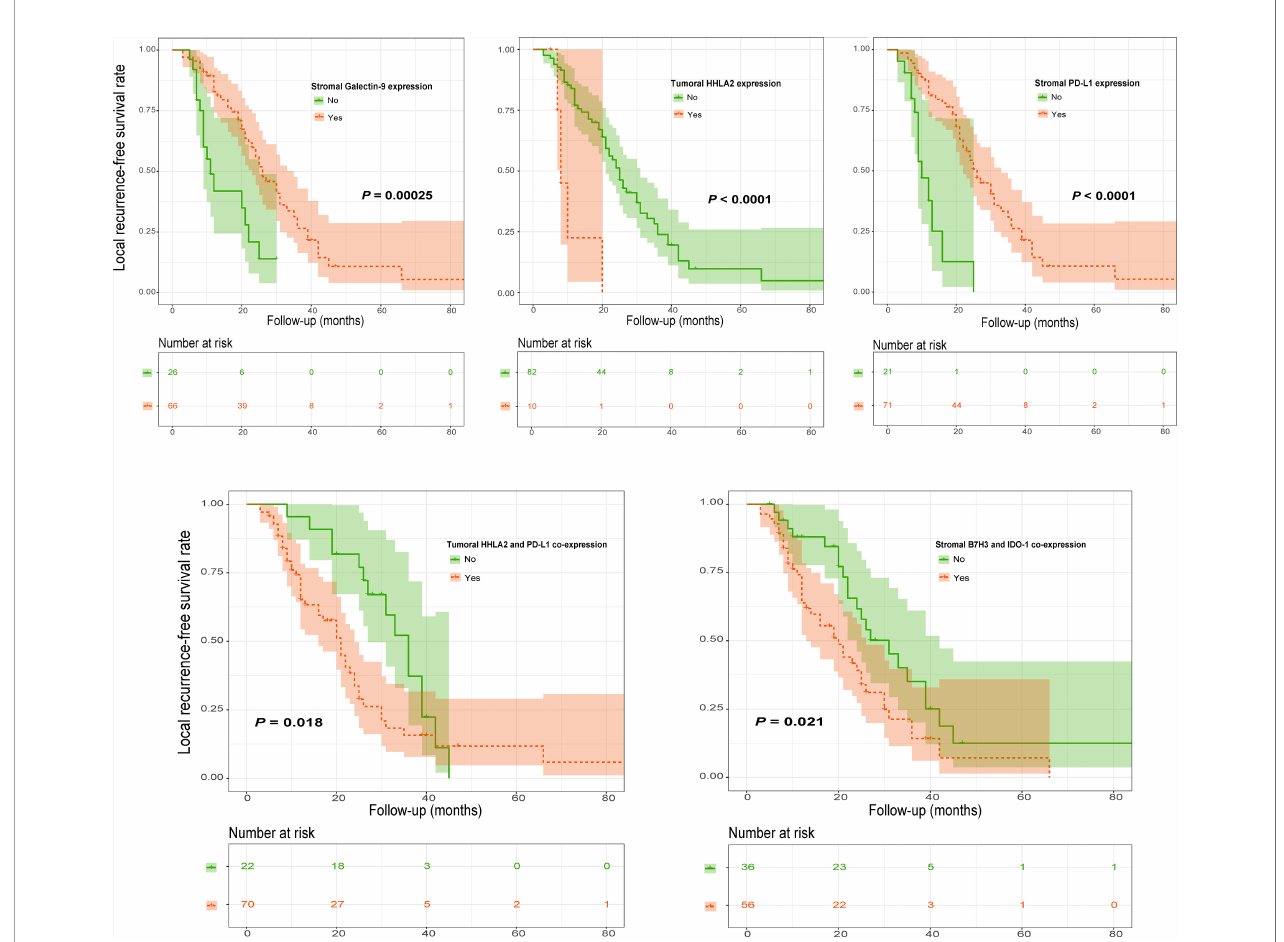
FIGURE 9 | Kaplan – Meier curves of LRFS of spinal chordoma patients strati fi ed by marker expression and coexpression status. LRFS, local recurrence-free